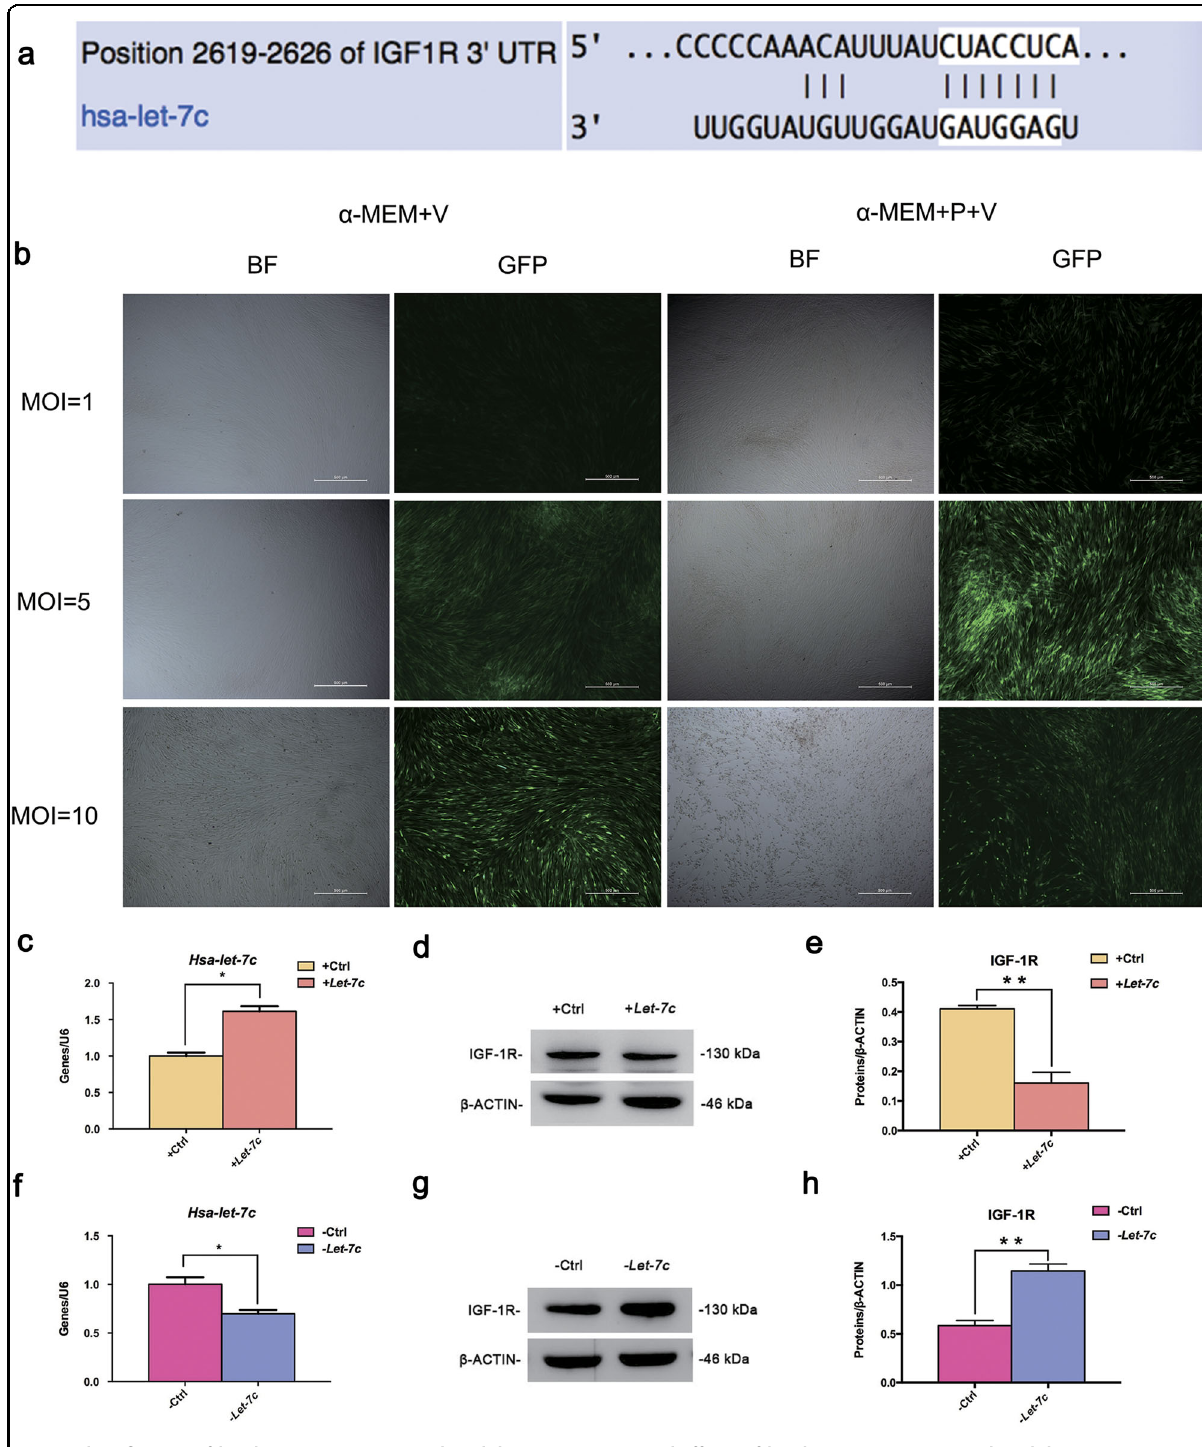
Fig. 2 Identi fi cation of hsa-let-7c overexpression/knockdown in DPMSCs and effects of hsa-let-7c overexpression/knockdown on IGF-1R. a The hsa-let-7c binding site within IGF-1R, as predicted by TargetScan. b Selection of optimal transfection conditions for let-7c lentivirus transfection. MOI the ratio of the lentiviral concentration to the number of cells, V lentivirus, P polybrene, BF bright fi eld, GFP green fl uorescent protein. c The levels of hsa-let-7c gene expression in + Let-7c and + Ctrl DPMSCs. Values are presented as the mean ± SD, n = 3. *1 < 2 − ΔΔ Ct < 2, P < 0.01. d The expression of IGF-1R protein in + Let-7c and + Ctrl DPMSCs, as determined by Western blot. e Quantitative analysis of d . ** P < 0.01. f The levels of hsa- let-7c gene expression in − Let-7c and – Ctrl DPMSCs. Values are presented as the mean ± SD, n = 3. *1 < 2 − ΔΔ Ct < 2, P < 0.01. g The expression of IGF- 1R protein in – Let-7c and – Ctrl DPMSCs. h Quantitative analysis of g . ** P <